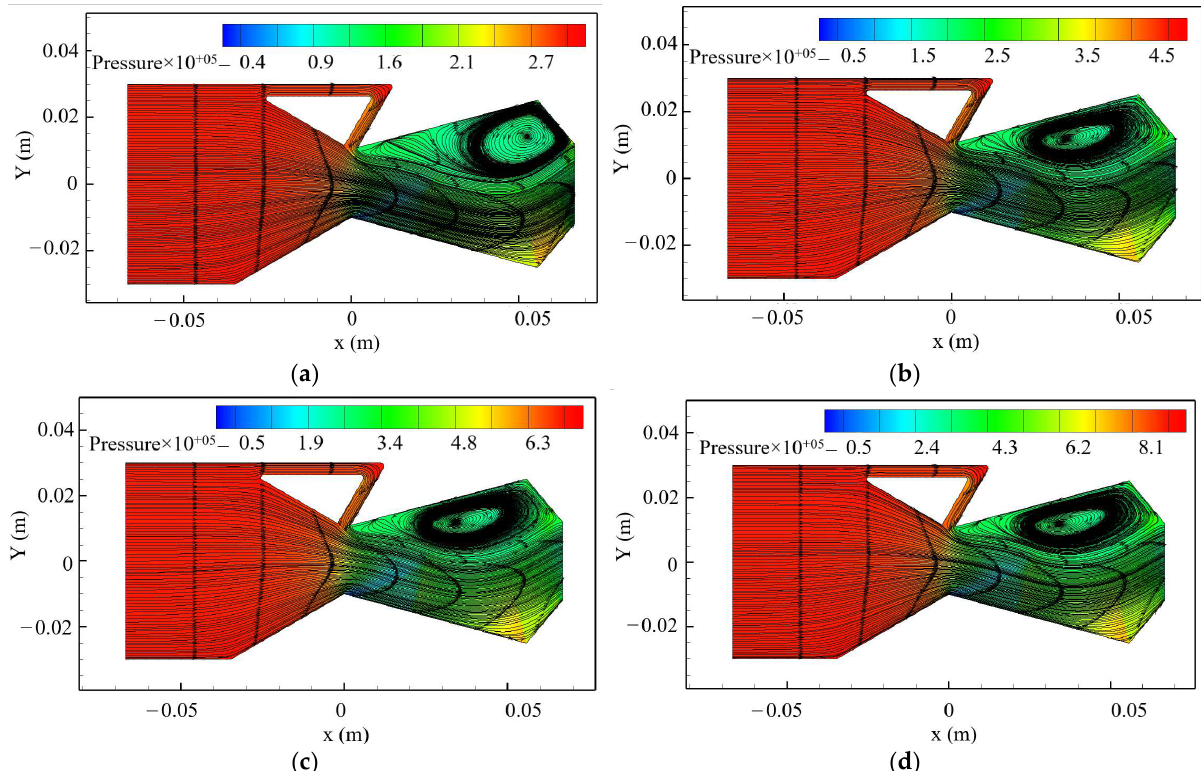
Figure 6. Vortex formation at the upper cavity wall at θ 2 = 50 ◦ , θ 1 = 30 ◦ and h b /h t = 0.185 for ( a )